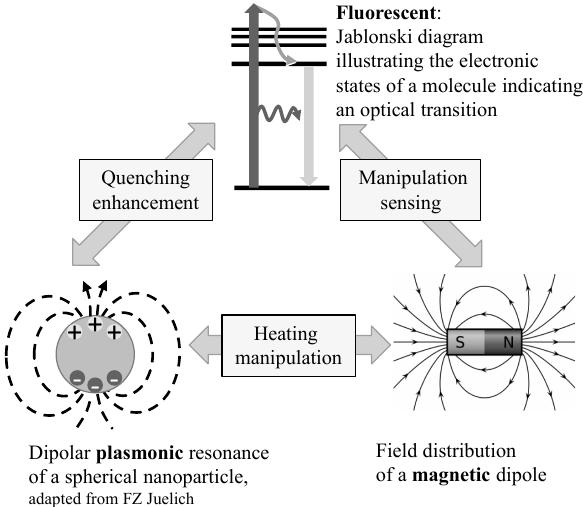
Figure 4. Properties for preparing bi- and trifunctional nano-objects and their bilateral interaction (adapted from [21]).